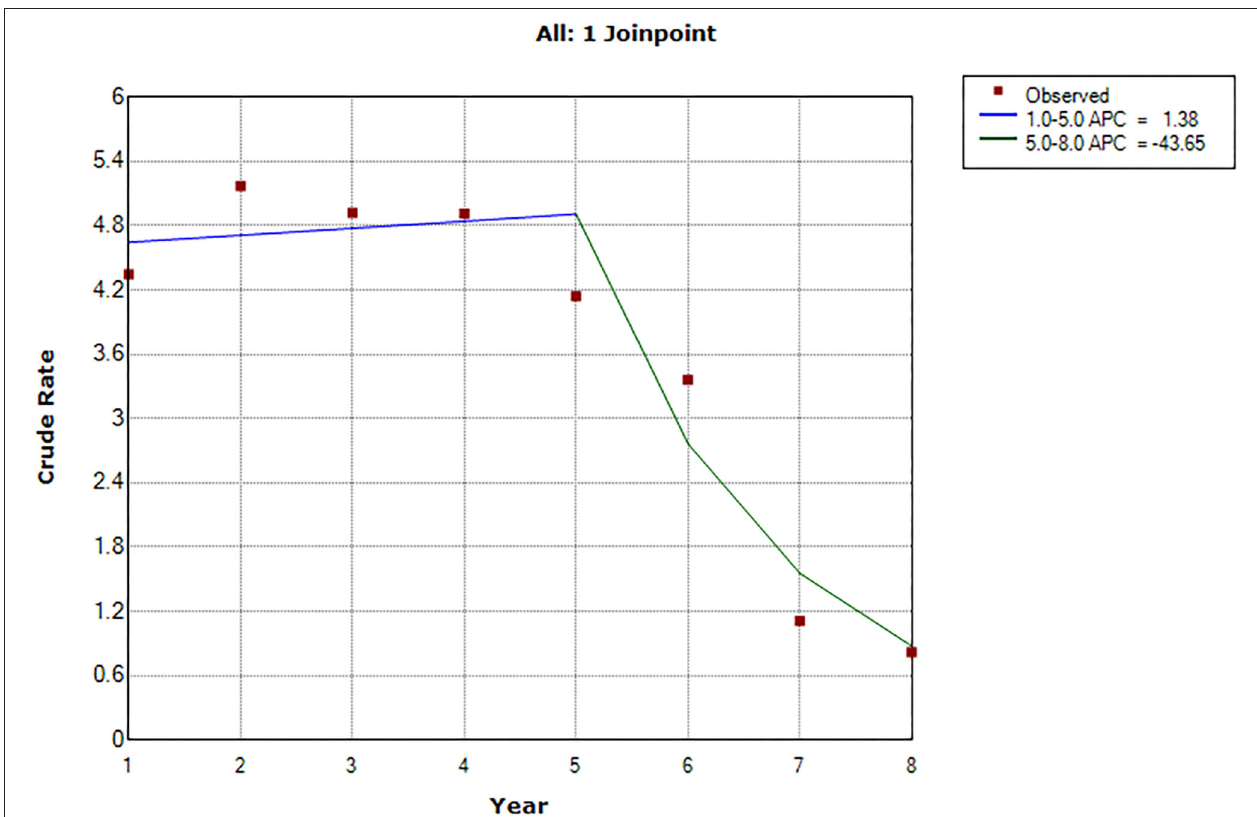
FIGURE 2 | APC of crude SUDEP incidence rate after 1–8 years of follow-up. Final Selected Model: 1